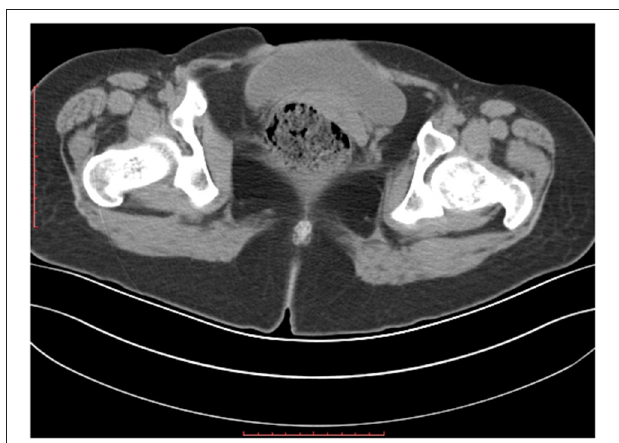
FIGURE 3 | Computed tomography showing the large fascial defect on the axial slices.